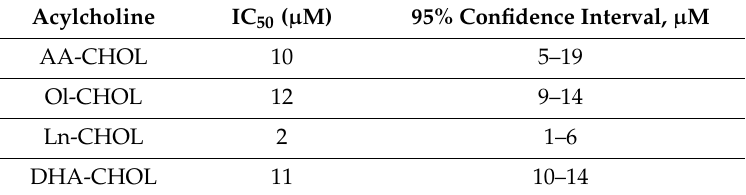
AA-CHOL also inhibited mouse muscle nAChR expressed in Xenopus laevis oocytes (Figure 3B) with IC 50 = 3.16 ± 0.26 µ